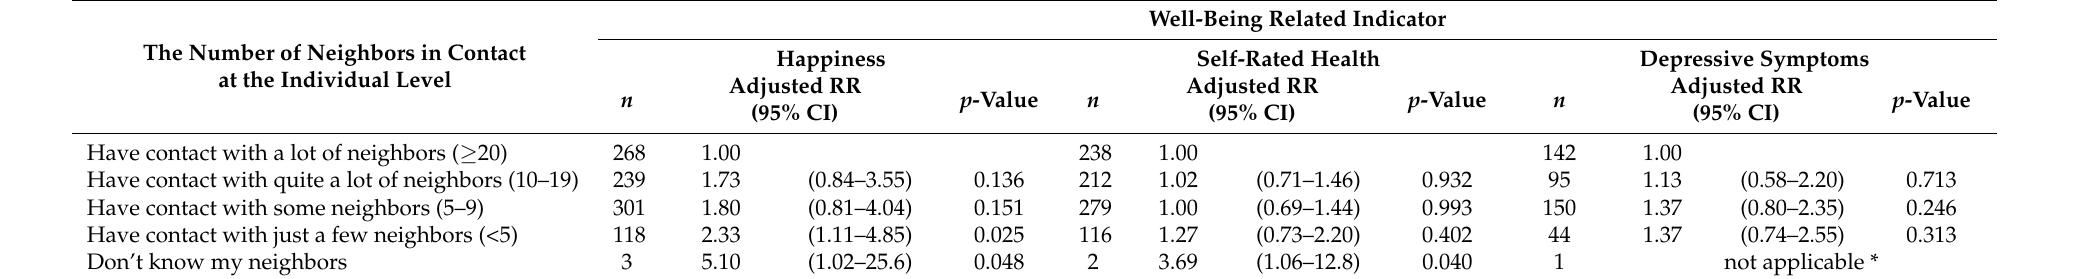
Table 3. The association of the number of neighbors in contact at the individual level with the decline in